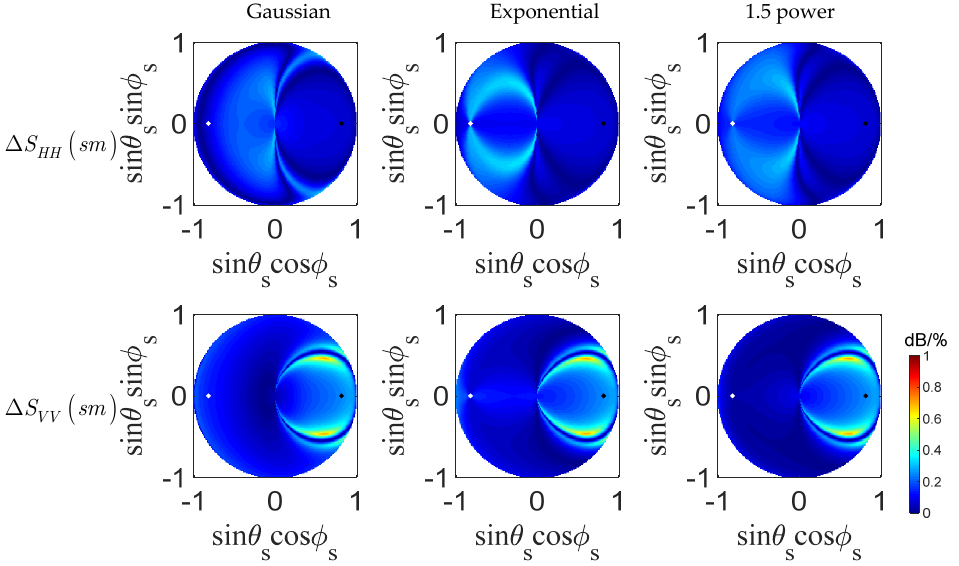
Figure 4. Patterns of single-co-polarized (HH or VV) sensitivity to soil moisture between 40% and 10%, obtained at Ku band, θ (cid:3036) = 55° and kl = 6.3 .